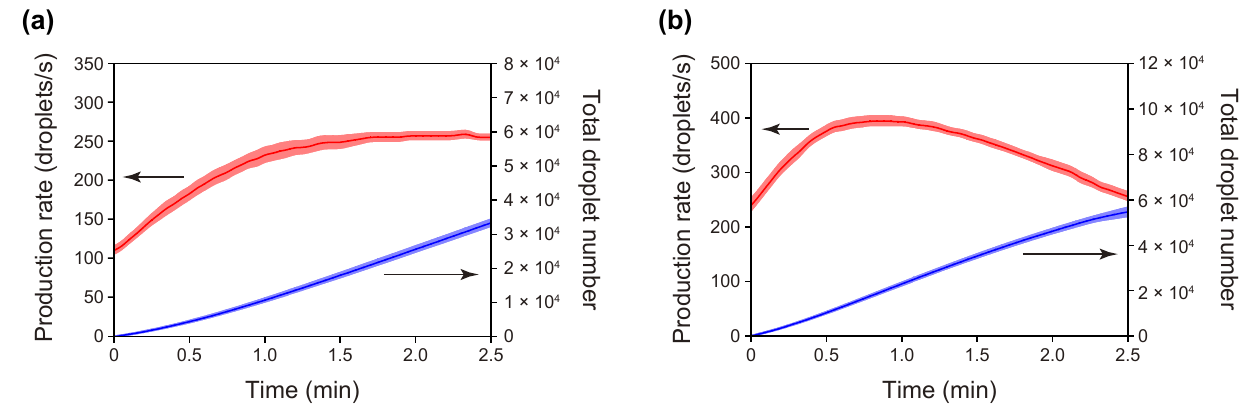
Figure 6. Changes in the rate of droplet production over the time-course of the experiments ( n = 5) for ( a ) the Variant II microchip and ( b ) the Variant III microchip. In each of the graphs, the red line shows the mean droplet production rate, while the blue line shows the mean total number of droplets produced, which was calculated by integrating the production rate with respect to time. The colored shaded areas above and below the lines represent ± 1 standard error of the